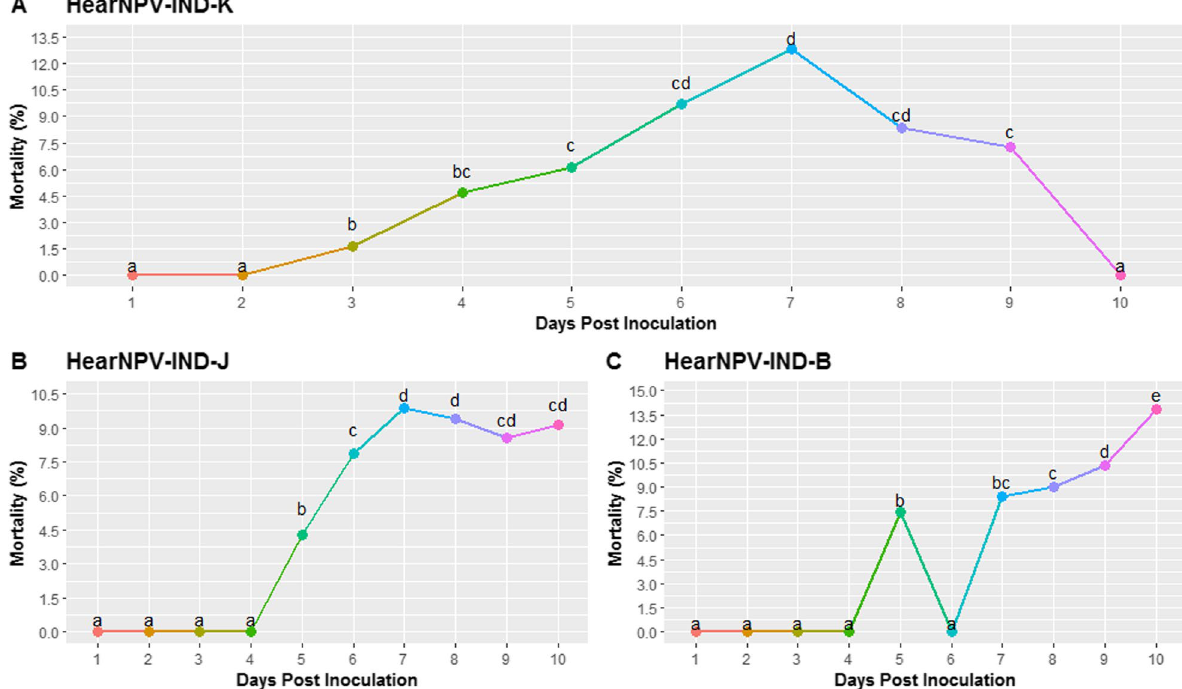
Fig. 1 Comparative daily mortality (%) of three different HearNPV isolates against 2nd instar Helicoverpa armigera larvae in time response bioassays. The first virus induced mortality was observed on day 3 with the HearNPV-IND-K isolate and day 5 with the other two isolates. The virus induced mortality peaked on 7th day with the HearNPV-IND-K and HearNPV-IND-J isolates and 10th day with the HearNPV-IND-B isolate. After 10th day, no further virus induced mortality was observed with all